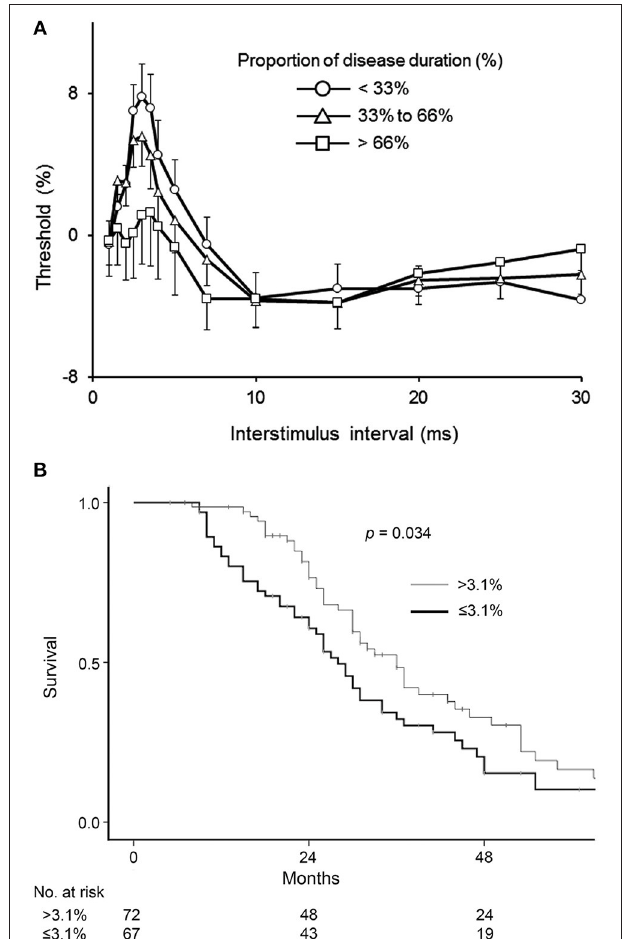
FIGURE 3 | (A) Cortical excitability changes with disease progression. Patients were divided into three groups according to disease stage. The duration of the illness from onset to death was normalized between zero and one and expressed as a percentage (%), with data averaged by proportion of disease duration. Early stage (Circle) was defined as the proportion of disease duration < 33%, mid (Triangle) was 33–66%, and late (Square) was > 66%. ALSFRS-R of patients in early stage was 42.3 ± 0.6, that in mid was 40.2 ± 0.7, and that in late was 34.8 ± 2.0. SICI at ISI 1–7ms decreased with disease progression. Data are given as mean ± SE. Reproduced with permission license no. 4456860473754 (70). (B) Kaplan-Meier plots of survival probabilities according to averaged short-interval intracortical inhibition (SICI) values. Amyotrophic lateral sclerosis patients with a disease duration under 2 years were divided into 2 groups according to values in average SICI, interstimulus interval 1–7ms. Patients with SICI ≤ 3.1% demonstrated reduced survival compared to patients with SICI > 3.1% ( p = 0.034). Estimated median survival was 28 months in patients with reduced SICI and 36 months in patients